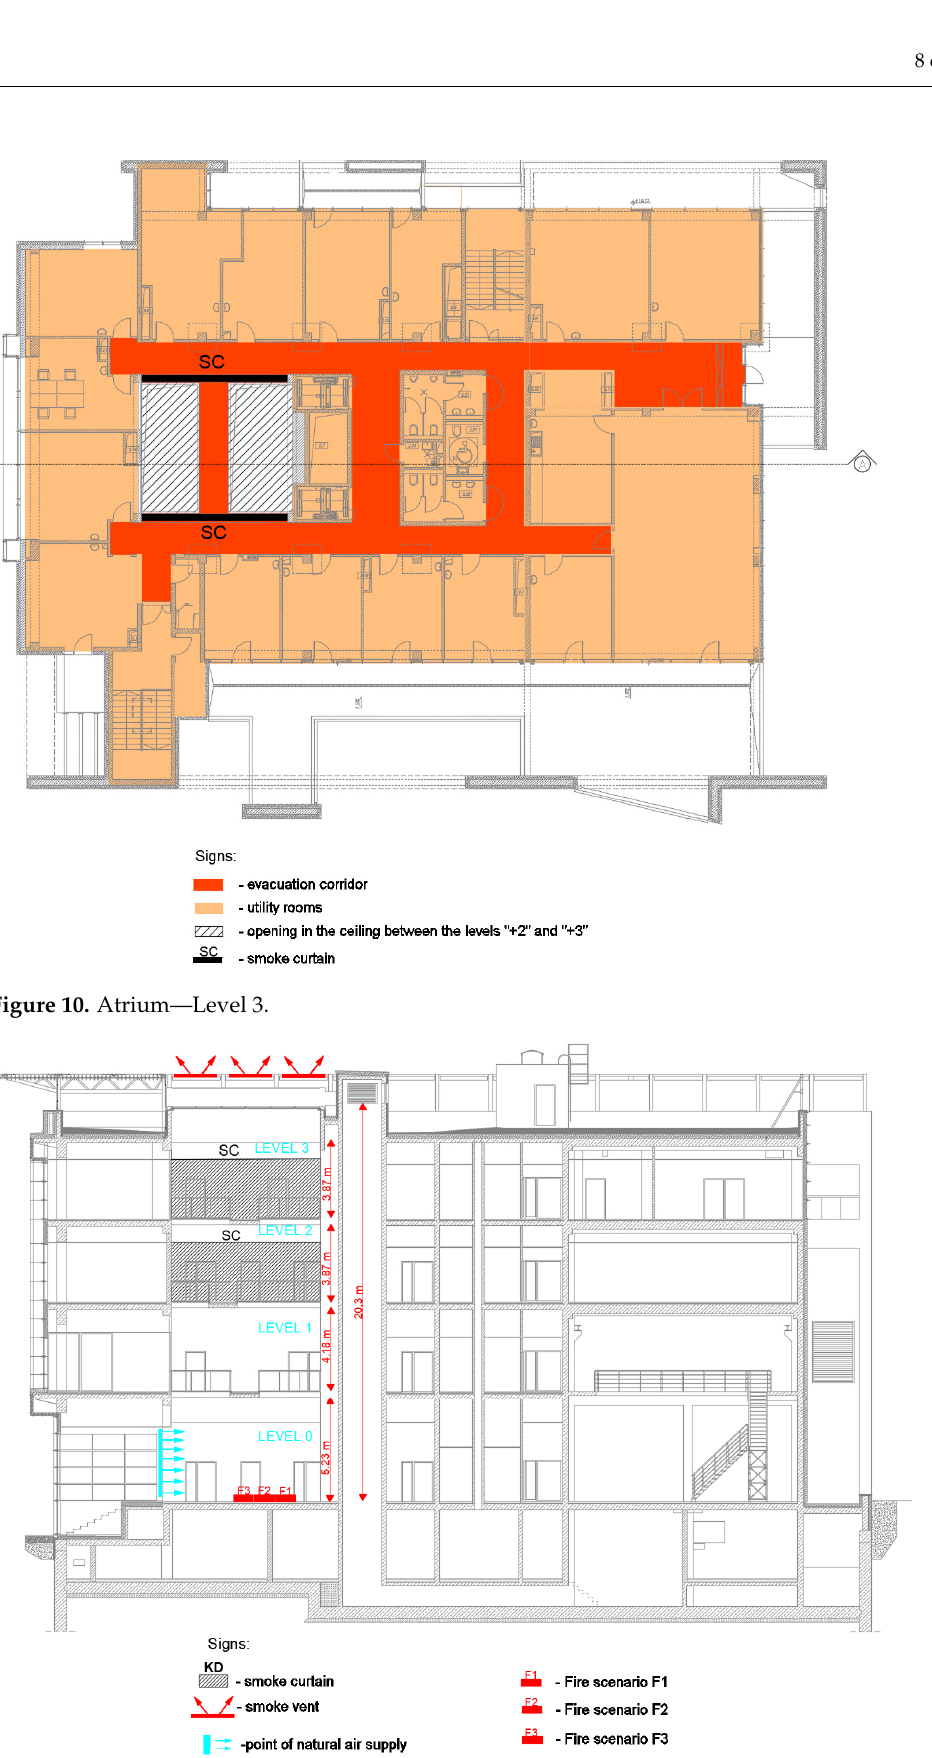
Figure 11. A cross-section of the atrium.